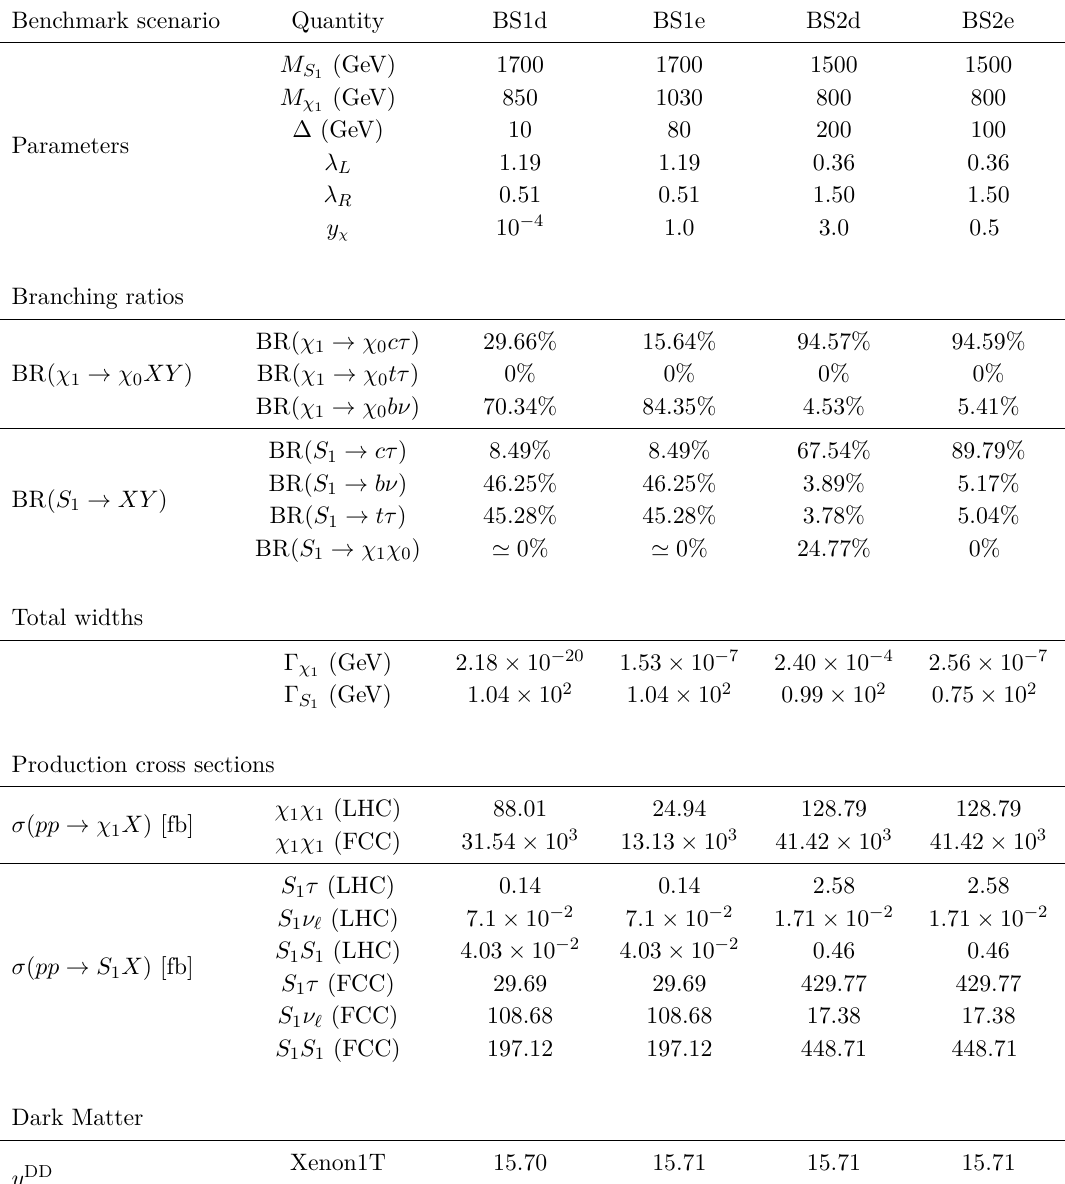
Table 4 . Benchmark scenarios in our model, compatible with an explanation for the R lies and that satisfy all constraints from cosmology and the LHC. For each point, we provide information on the new state branching ratios, total widths and LO production rates at the LHC, as well as on the current and future bounds from DM direct